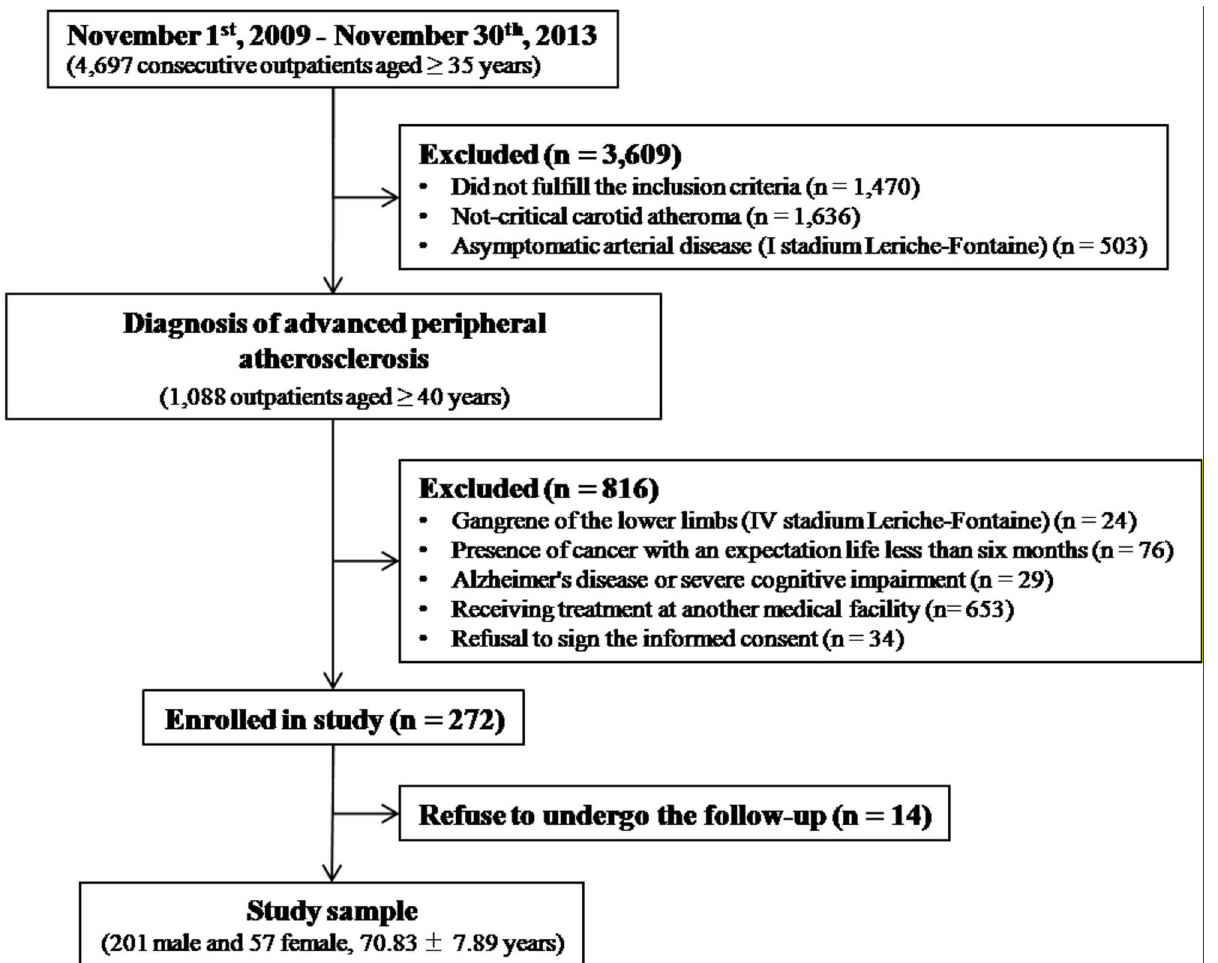
Fig 1. Summaryof the study